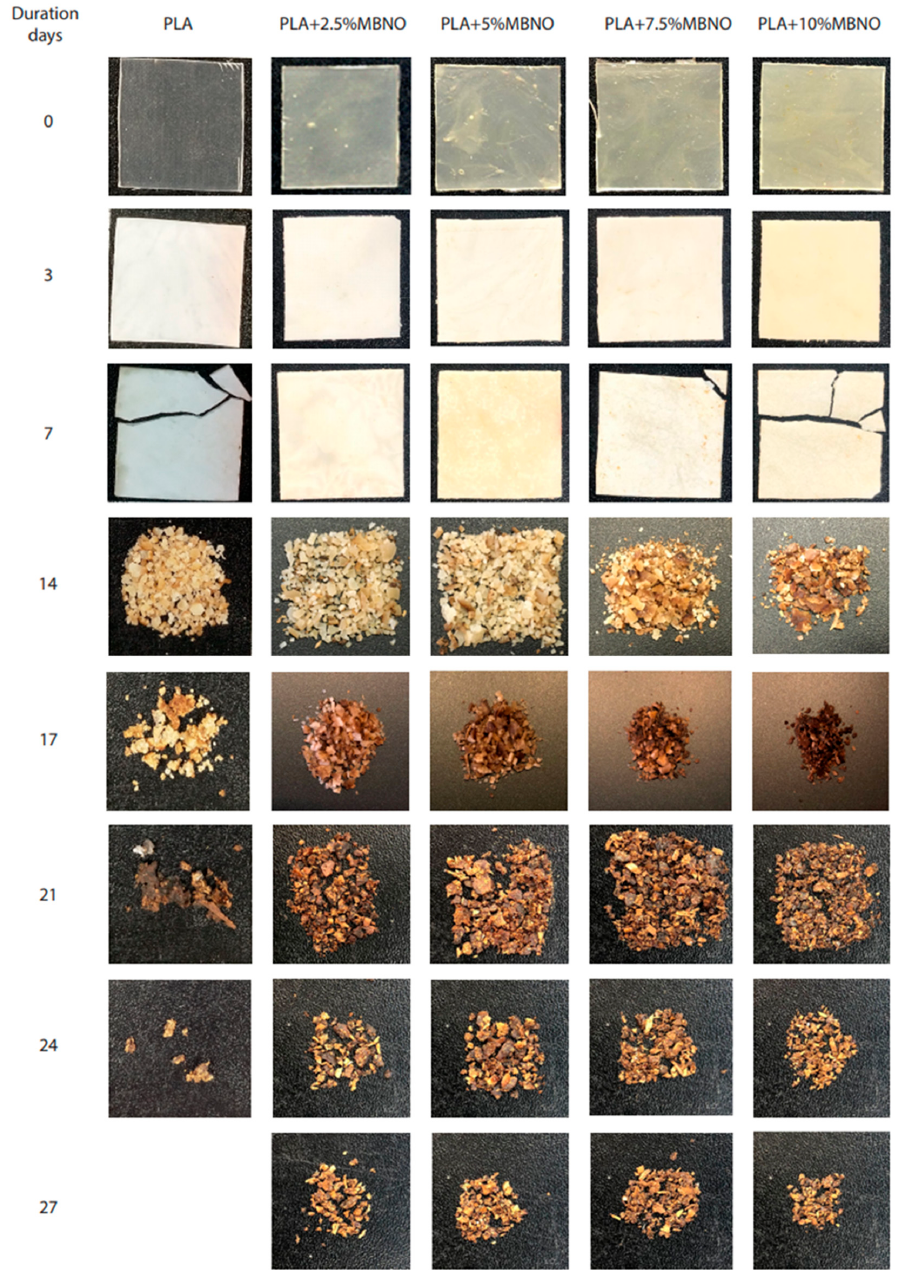
Figure 11. Visual appearance of disintegration under composting conditions of PLA and PLA plasticized with different contents of MBNO.